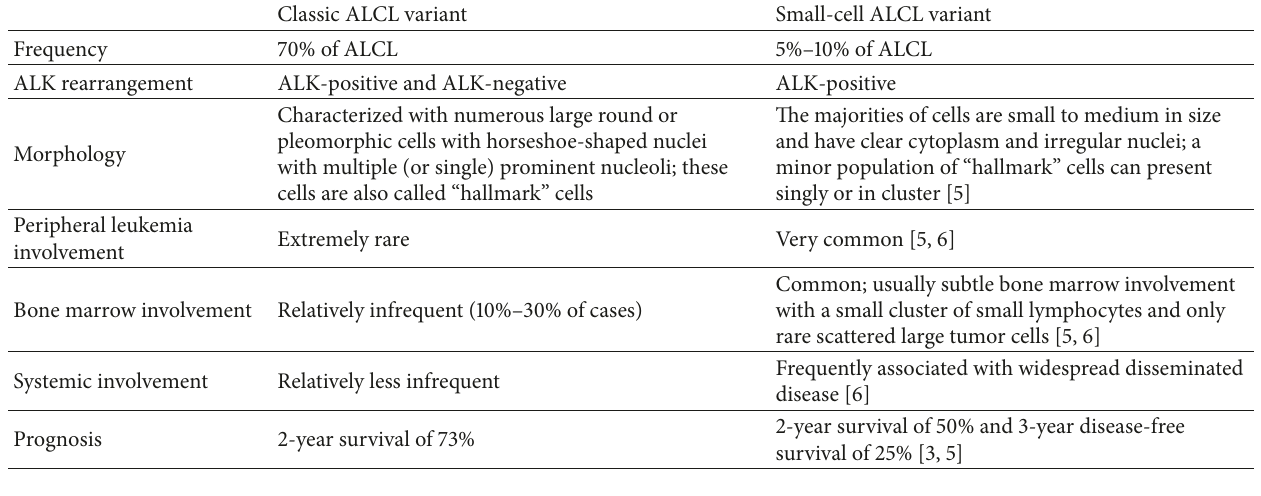
Table 2: Comparison of classic and small-cell variant ALCL.